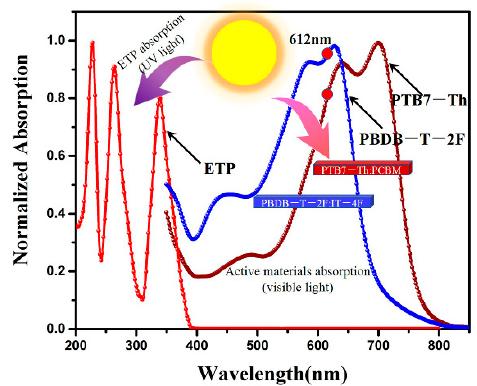
Figure 10. UV / visible absorption spectra of ETP, PTB7-Th–PC 71 BM, and PBDB-T-2F–IT-4F (the red circle symbolizes the peak position in the ETP emission spectrum; the arrows symbolize that UV light and visible light are absorbed by the ETP and active layer materials, respectively).